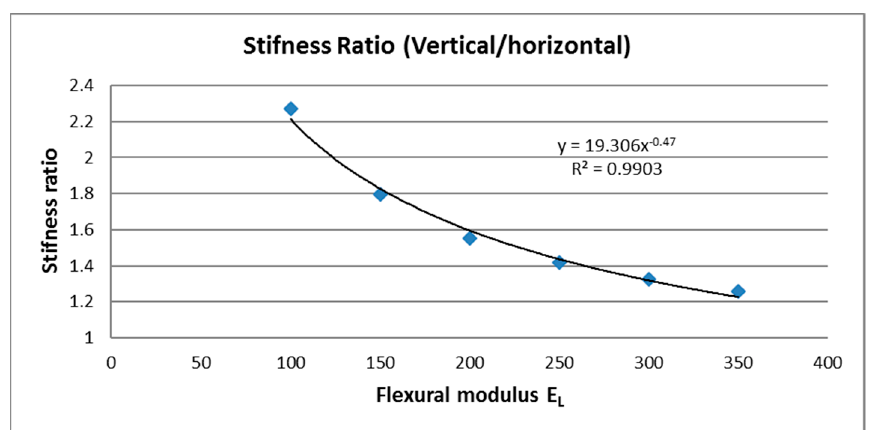
Figure 11. Estimation of flexural E modulus of inter-columnar resin (E L ). Visijet FTX.